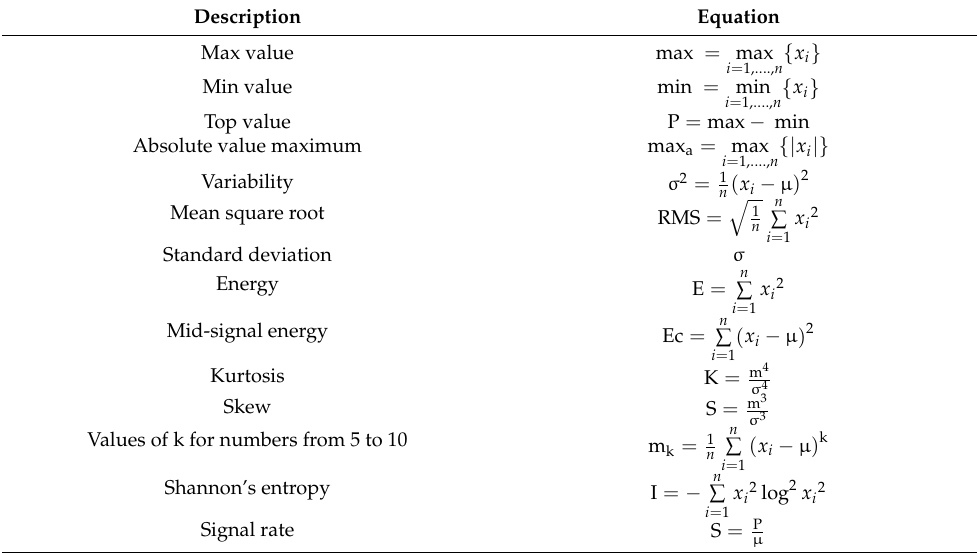
Table 1. List of extracted information from input